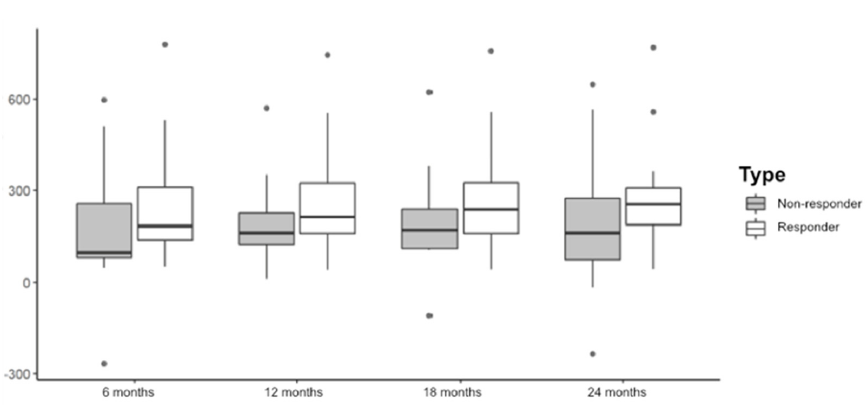
Figure 1. BCVA (logMAR) regarding diagnosis.